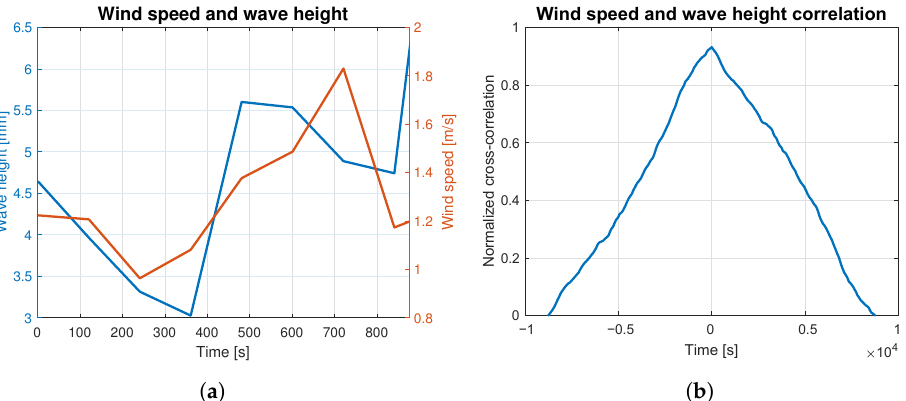
Figure 4. Wind speed and wave height correlation for 4 BFT: ( a ) wind speed and wave height measurements; ( b ) wind speed and wave height